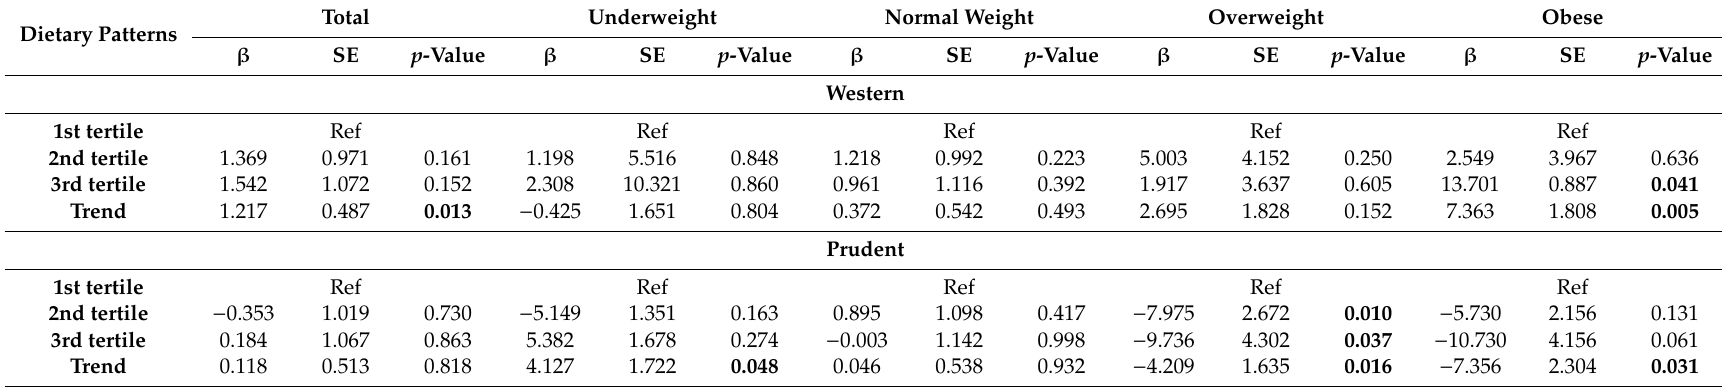
Table 4. Linear regression of the association between dietary patterns and gestational weight gain, stratified by body mass index categories. Total Underweight Normal Weight Dietary Patterns